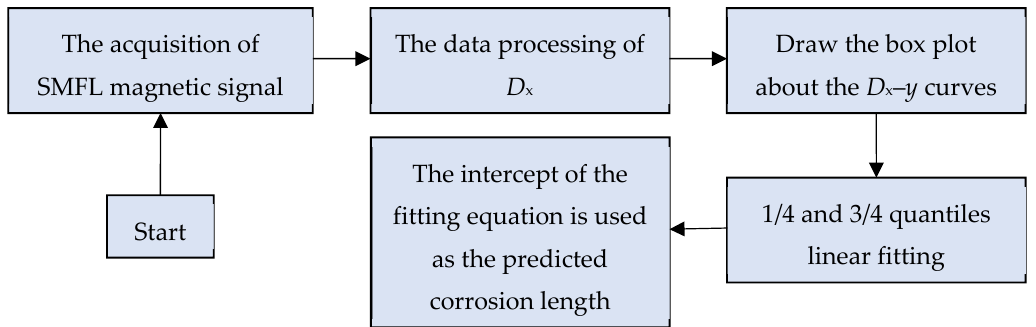
Figure 13. The flow chart of corrosion width prediction method.